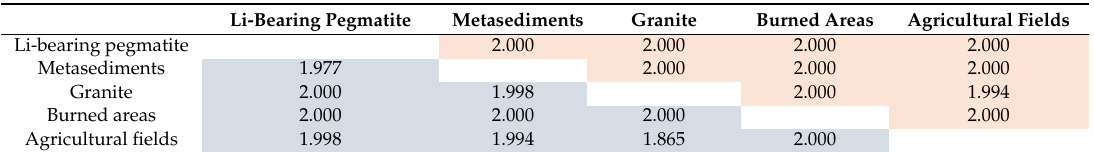
Table 3. Jeffries–Matusita (JM) (Blue) and transformed divergence (TD) (Orange) Separability for Each Pair of Measures for Each Pair of Classes.